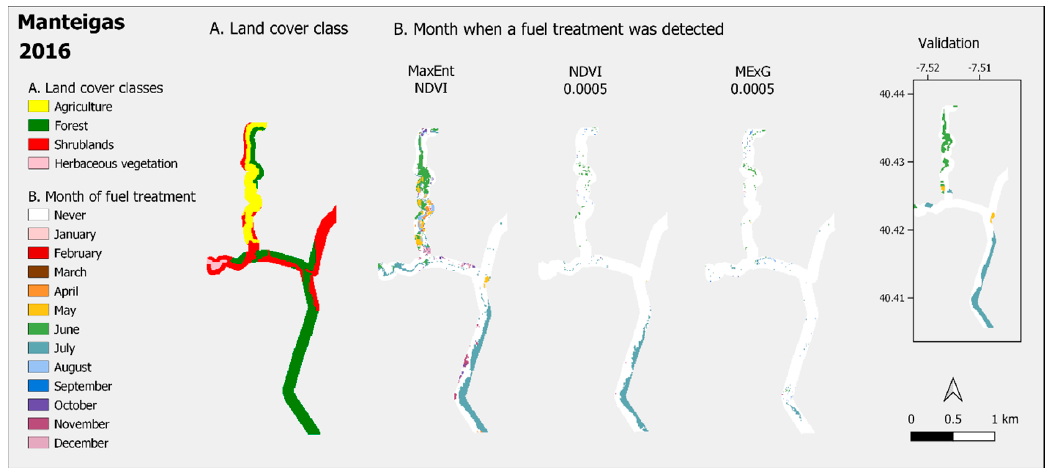
Figure 11. Results in Manteigas for the year 2016: A. Land cover; B. results of Method 1, MaxEnt NDVI classification, and Method 2, NDVI and MExG statistical detection with α = 0.0005.